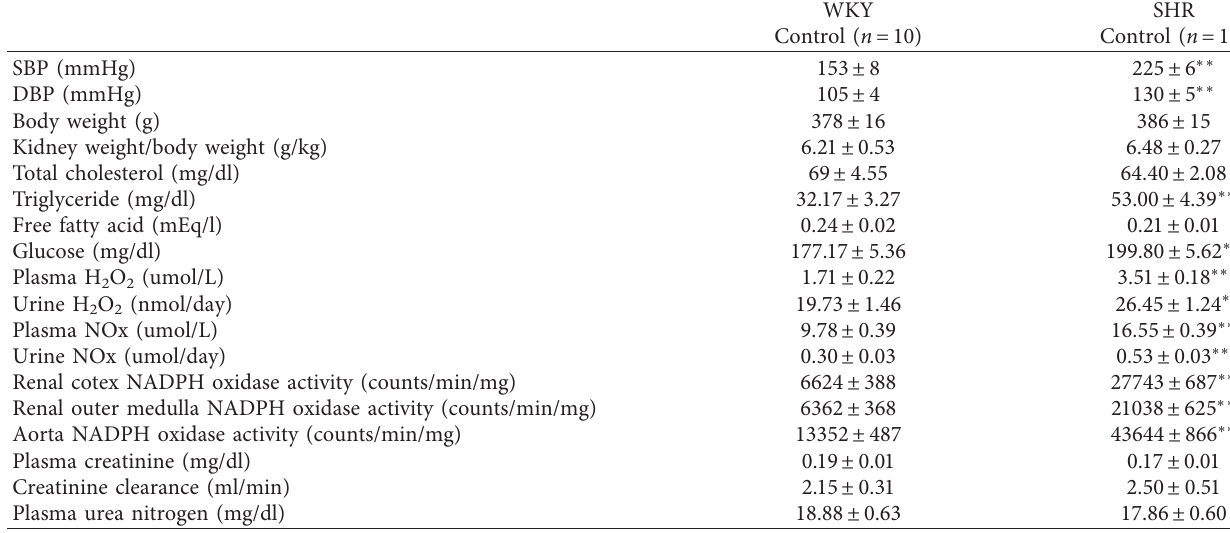
Table 1: The SBP and biochemical variables in SHR control and WKY control.